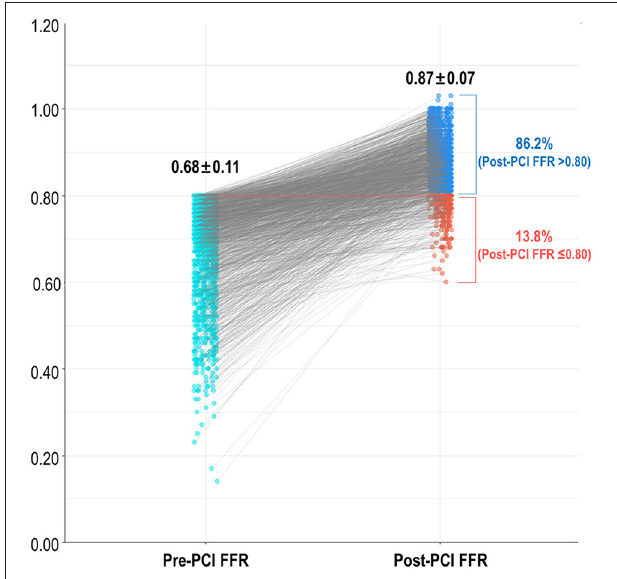
FIGURE 1 | Frequency of residual ischemia after FFR-guided revascularization. FFR, fractional flow reserve; PCI, percutaneous coronary intervention.